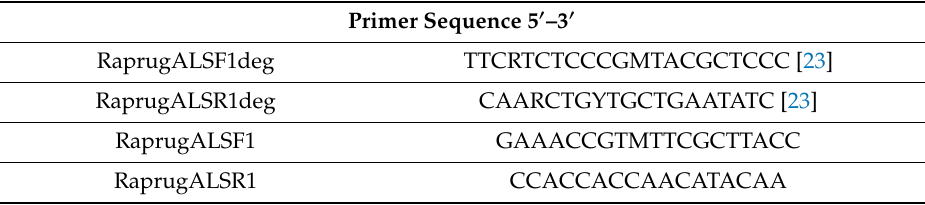
Table 2. List of primers used to amplify a fragment of the ALS gene of R. rugosum. Primer Sequence 5 (cid:48) –3